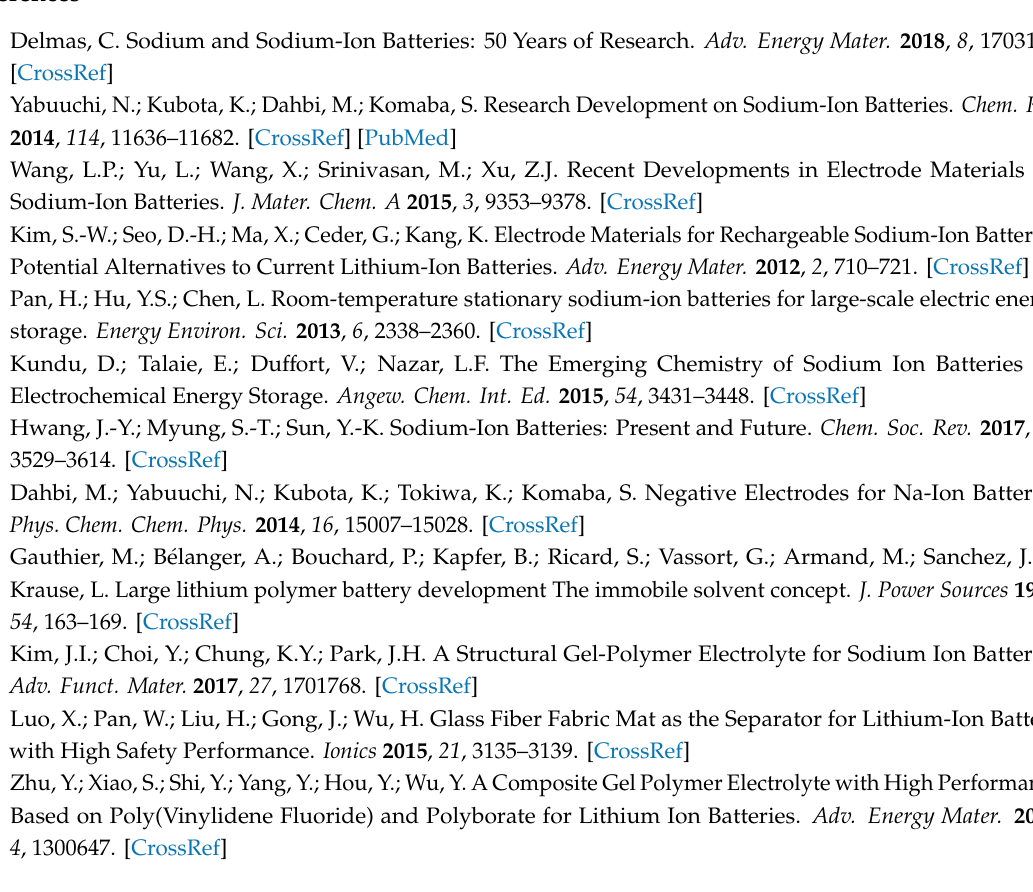
Table S1: Physical properties of membrane with di ff erent weight ratios of PVdF-SiO 2